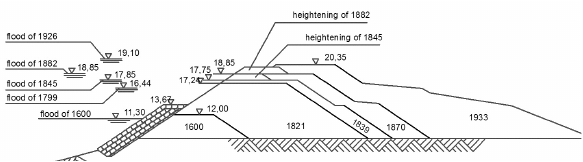
Fig. 2. Historical evolution of the high water levels (left) and levees (right) in the Adige River at Masi (Italy) between 1600 and 1933 (after Da Deppo et al.,